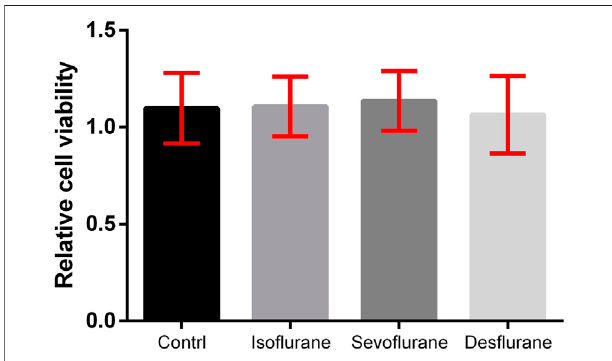
FIGURE 1 | Effect of inhaled anesthetics on the viability of 4T1 cells in vitro . The 4T1 cells were treated with air (control), 2% iso fl urane, 3.6% sevo fl urane, or 10.3% des fl urane for 3 h. Cell viability was determined using the MTT assay. There was no signi fi cant difference between the four groups ( n = 180, P = 0.648). Iso fl urane vs. control, P = 0.684; sevo fl urane vs. control, P = 0.541; des fl urane vs. control, P = 0.363; one-way ANOVA + Tukey ’ s multiple comparisons